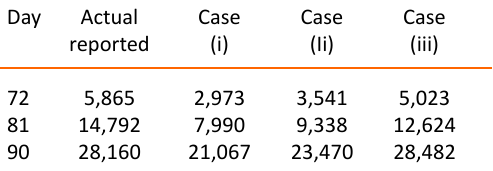
Table 3. Comparison of actual reported cases in India on days 72, 81 and 90 22 with the data predicted using the sigmoid